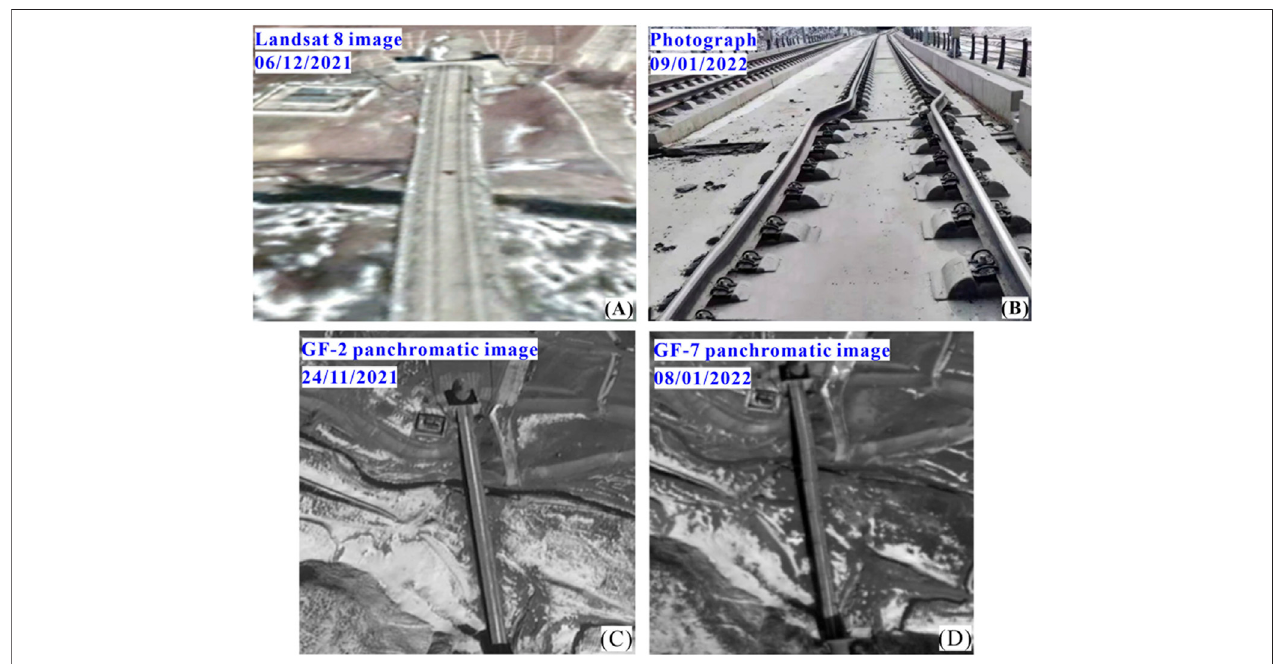
FIGURE 12 | Comparison of damage to the Daliang tunnel in the section from Menyuan to Minle. The type of image and the time it was taken are marked in blue.